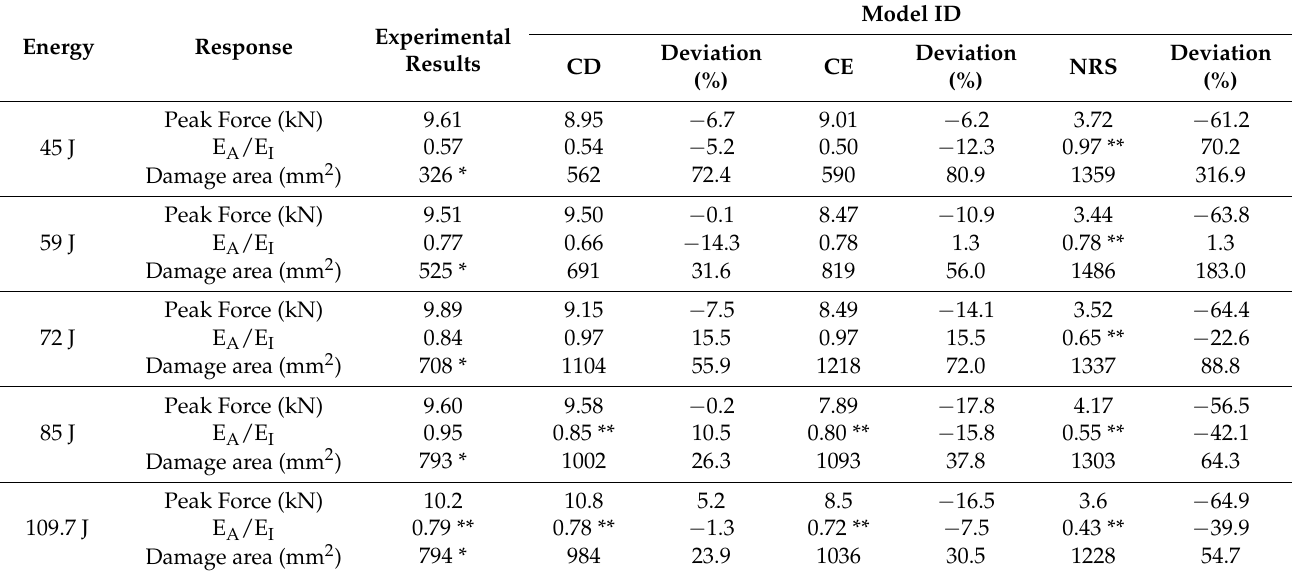
Table 3. Comparison of experimental and numerical results of peak impact force, absorbed energy, impact energy ratio (E A /E I ), and damage area.